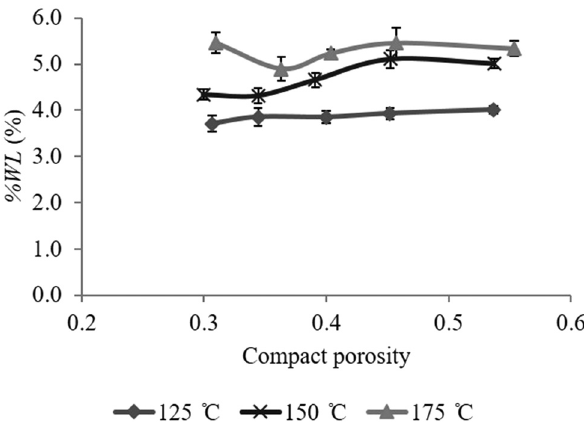
Figure 6: Relations between average values of % WL of compacts and compact porosity before heat treatment at di ff erent heat treatment temperatures. Error bars represent ± standard deviation, n = 5.